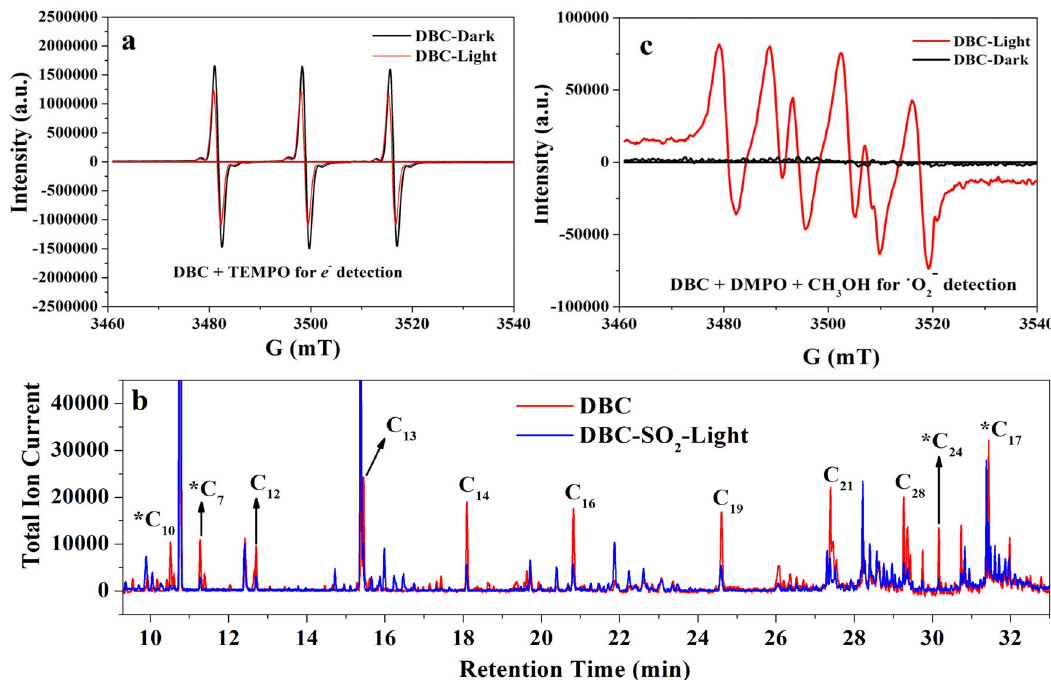
Fig. 3 | Reactive intermediates on DBC under light irradiation. TEMPO spin- trapping ESR spectra for the detection of electrons in DBC suspension ( a ). Com- parison of OCsignalsfrom fresh DBCand DBC aged bySO 2 under lightirradiation, *C represents aromatic hydrocarbon with different functional groups (such as